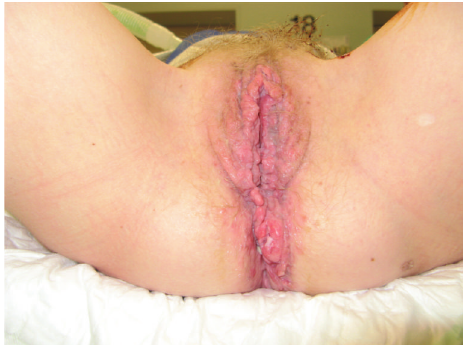
Figure1:Extensivecondylomaacuminataofthevulvarandperianal regions.